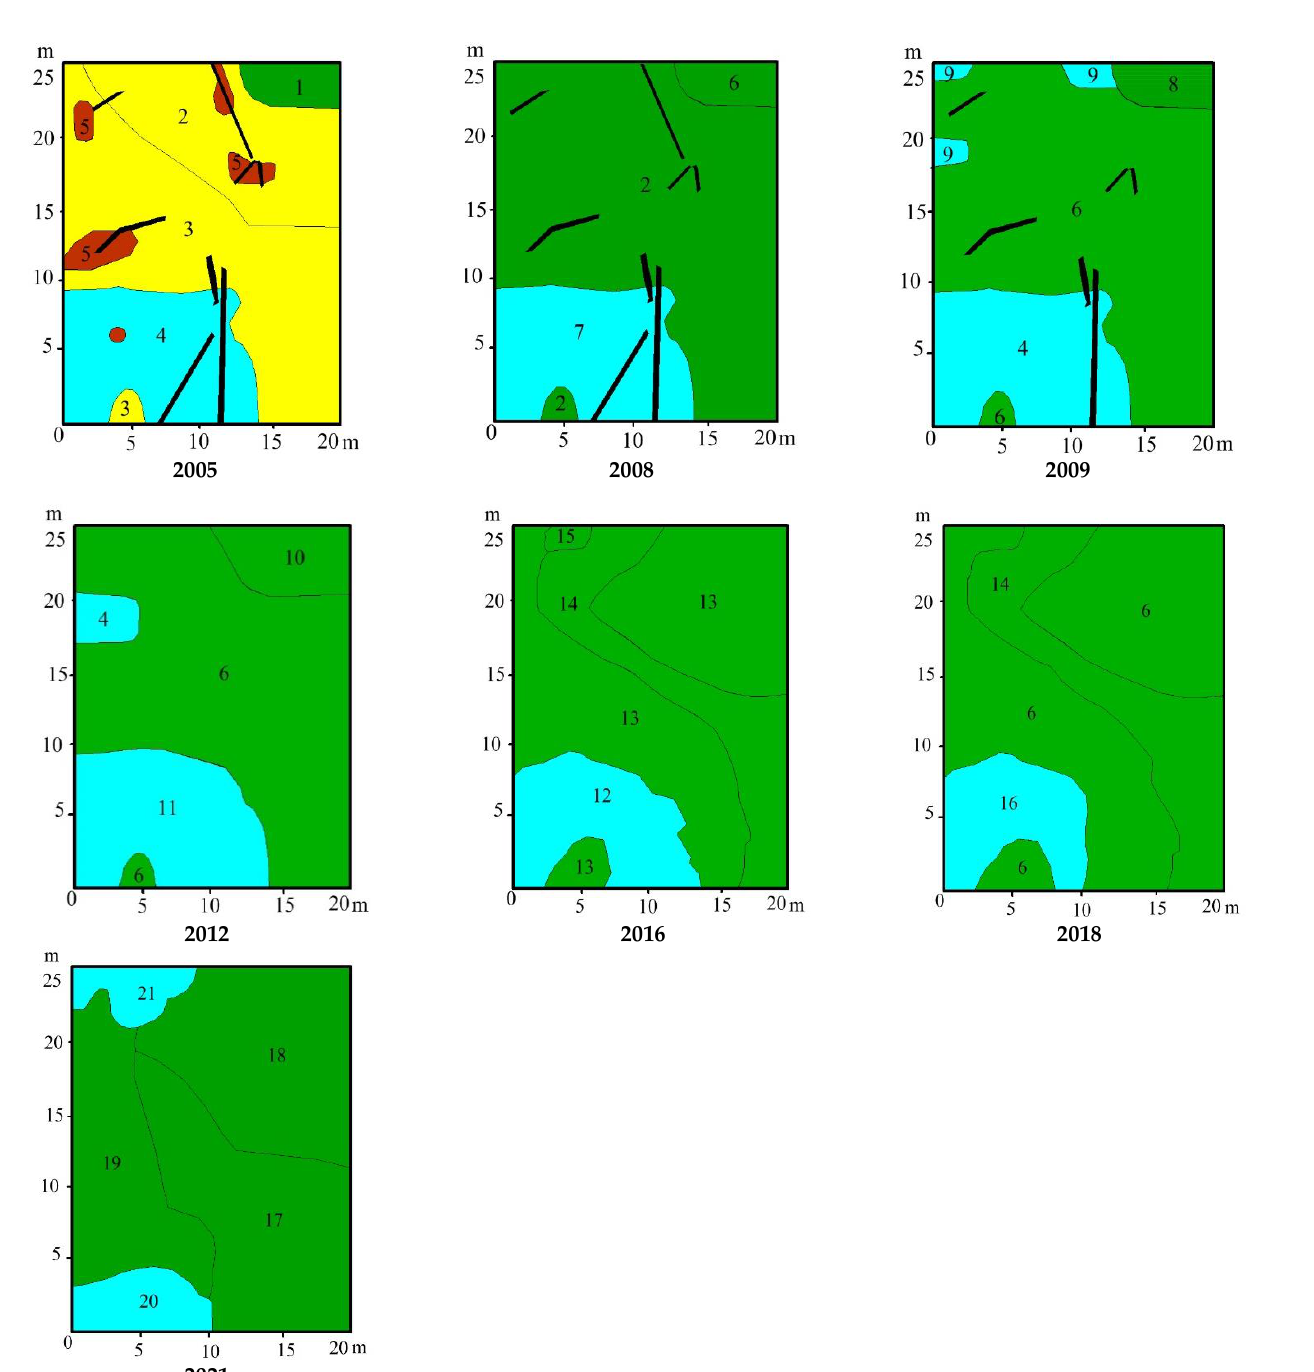
Figure 14. Changes in vegetation on permanent plot No. 8: 1 Betula pubescens – Salix cinerea ; 2 Cala- magrostis epigejos + Molinia caerulea ; 3 Salix aurita – C. epigejos + Epilobium adenocaulon – Marchantia